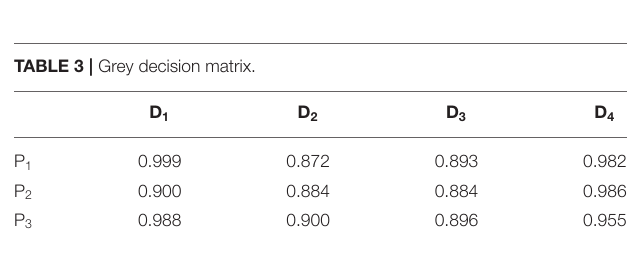
TABLE 4 | Hurwicz’s evaluations. Optimistic approach: by keeping α = 0.3 and thus, 1– α =